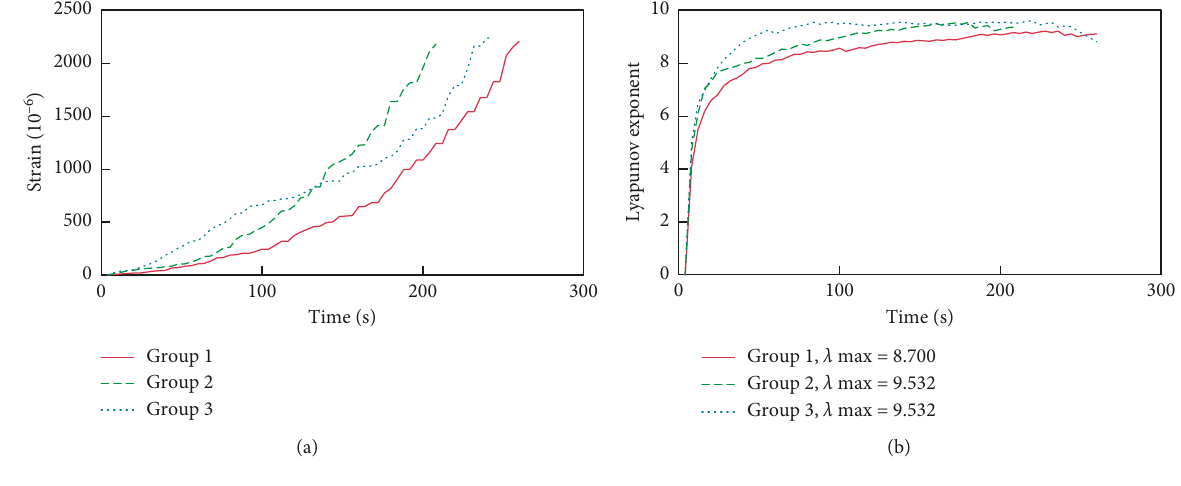
Figure 6: Strain-time curve and LE-time curve of fitted